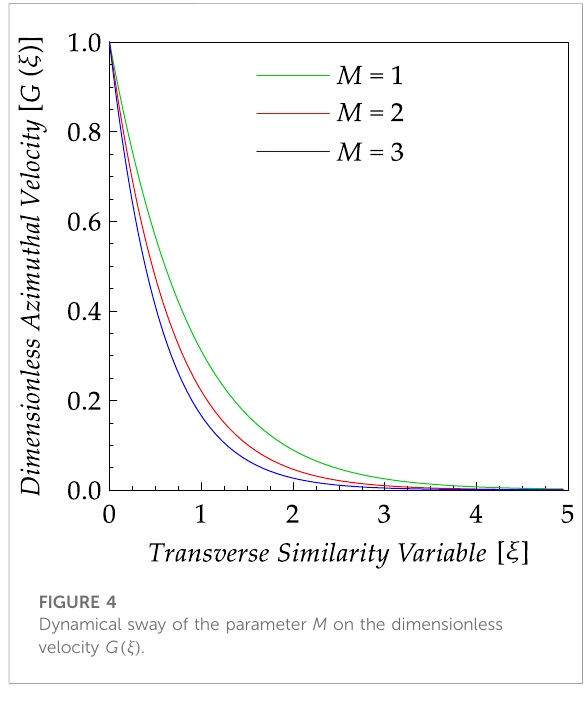
FIGURE 4 Dynamical sway of the parameter M on the dimensionless velocity G ( ξ )